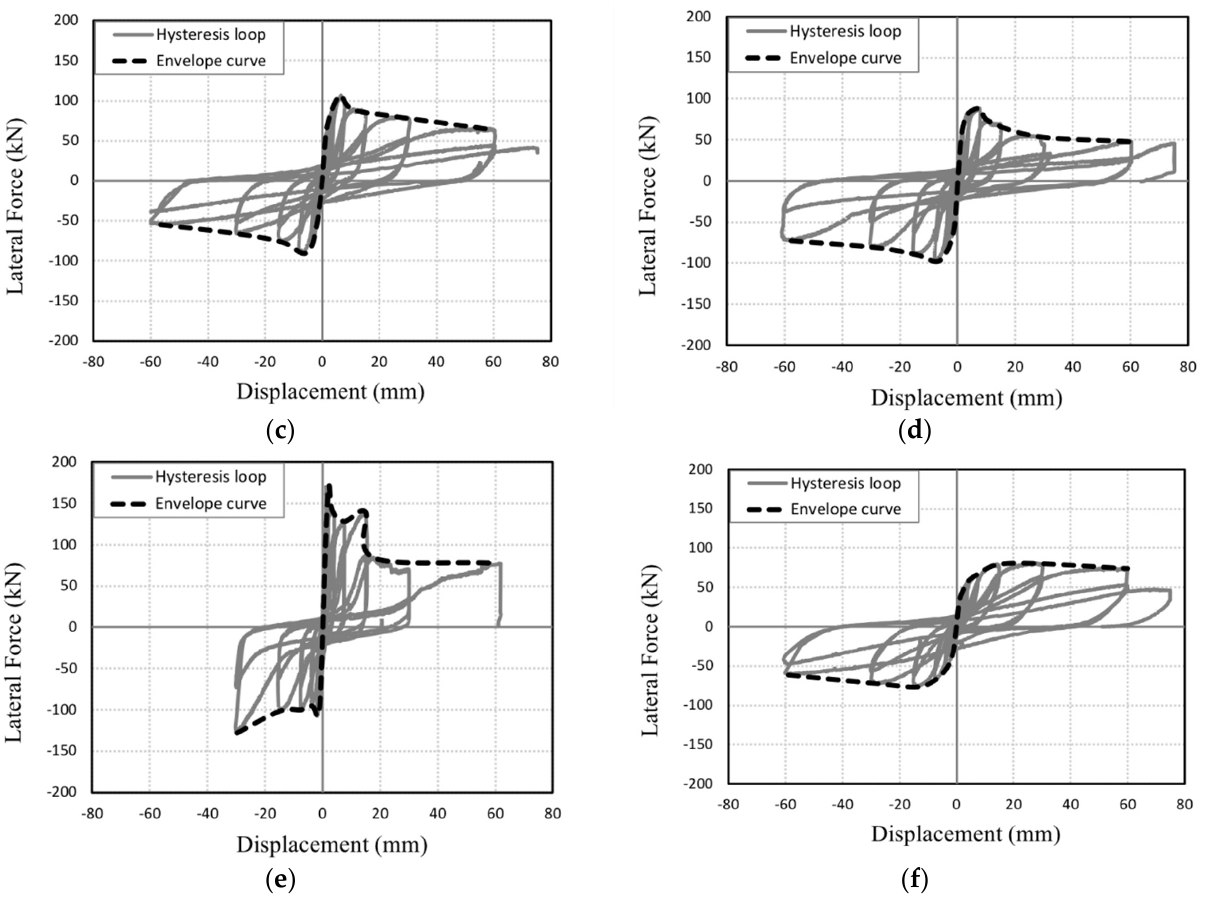
Figure 7. Lateral force-displacement relationships for all specimens: ( a ) IFSW specimen, ( b ) IFSM − A specimen, ( c ) IFSM − P specimen, ( d ) IFSM − S specimen, ( e ) IFSM − FRM specimen, and ( f ) IFSM − PW specimen.